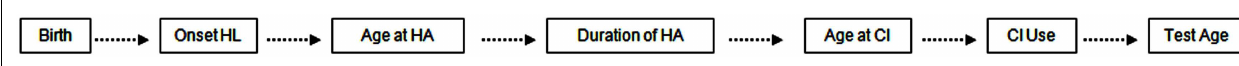
FIGURE 1 | Demographic factors occurring over a child’s life that could affect access to sound and auditory development.